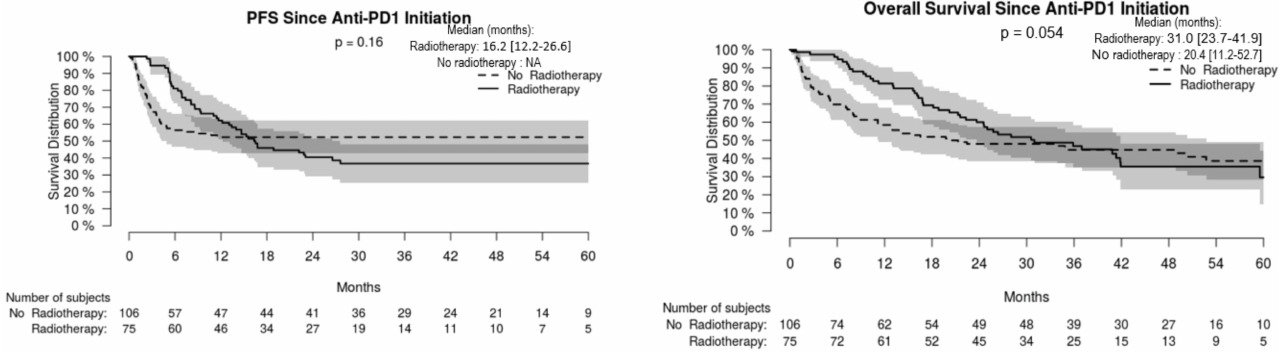
Figure 3. Progression-free (PFS) and overall (OS) survival in radiated melanoma patients having received hypofractionated radiotherapy and non-radiated melanoma